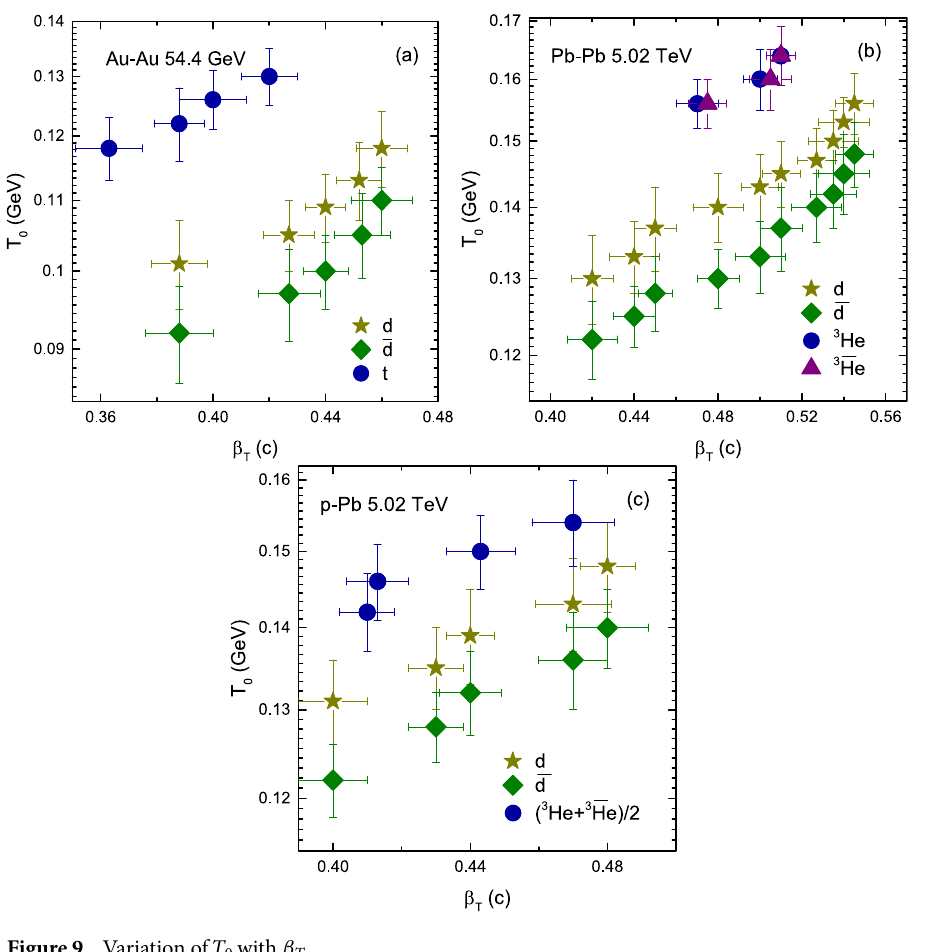
Figure 9. Variation of T 0 with β T